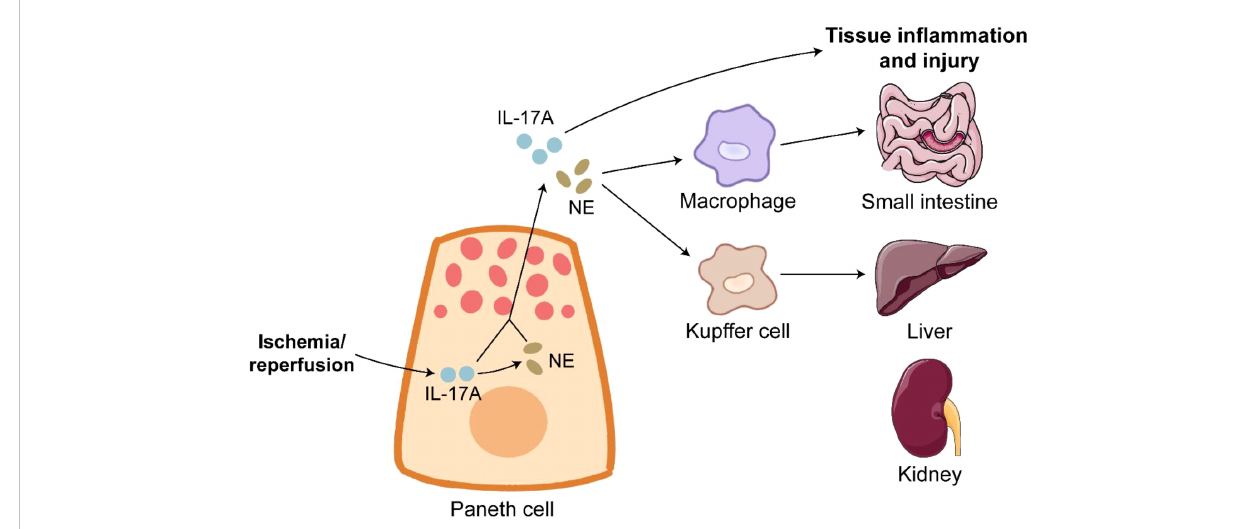
FIGURE 3 Paneth cells in ischemia/reperfusion. Ischemia/reperfusion triggers robust degranulation in Paneth cells. IL-17A release from Paneth cells directly leads to in fl ammation and injury of organs such as small intestine, liver and kidney. Furthermore, IL-17A in Paneth cells promotes the expression of NE. NE binds to its receptor on macrophages and Kupffer cells to induce tissue in fl ammation and injury.